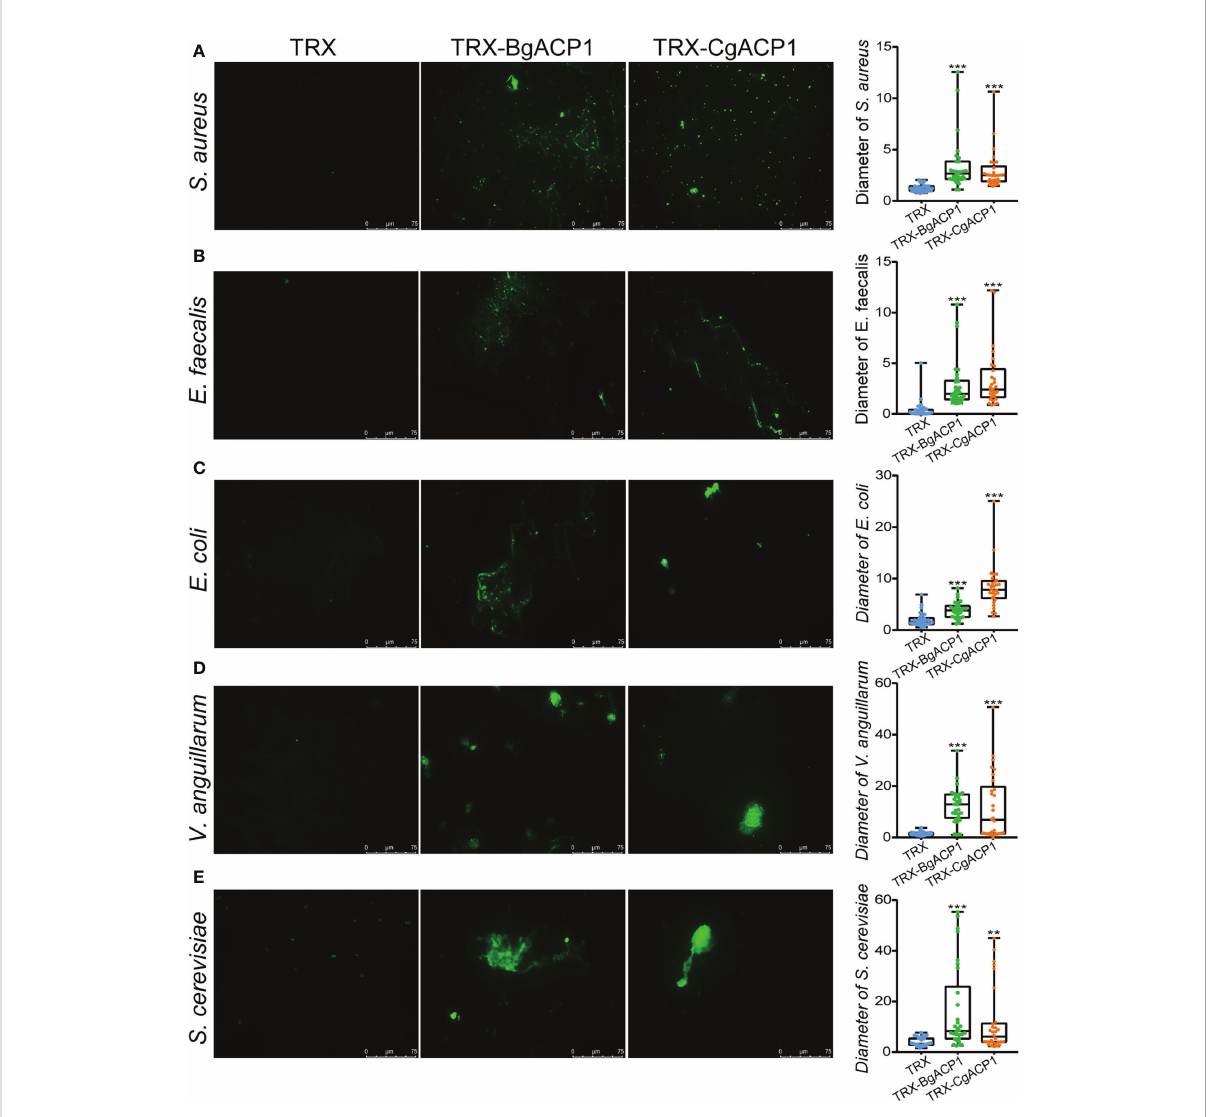
FIGURE 5 The bacterial agglutinating capacity of recombinant CgACP1 and BgACP1. (A – E) Agglutination of the different microbes by TRX-CgACP1 and TRX-BgACP1. The diameters of green puncta in microbial aggregation assays were measured by boxplot and shown on the right panels. Boxplot explanation: upper horizontal bar outside box, maximum value; lower horizontal bar outside box, minimum value; upper horizontal line of box, 75th percentile; lower horizontal line of box, 25th percentile; horizontal bar within box, median; ** p < 0.01, *** p < 0.001 versus TRX